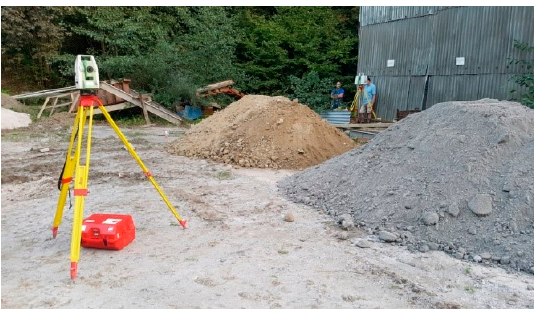
Figure 12. Measurement of the volume of loosened raw material—perlite from Probe 1 and Probe 2 at the LBK Perlit site using TLS.